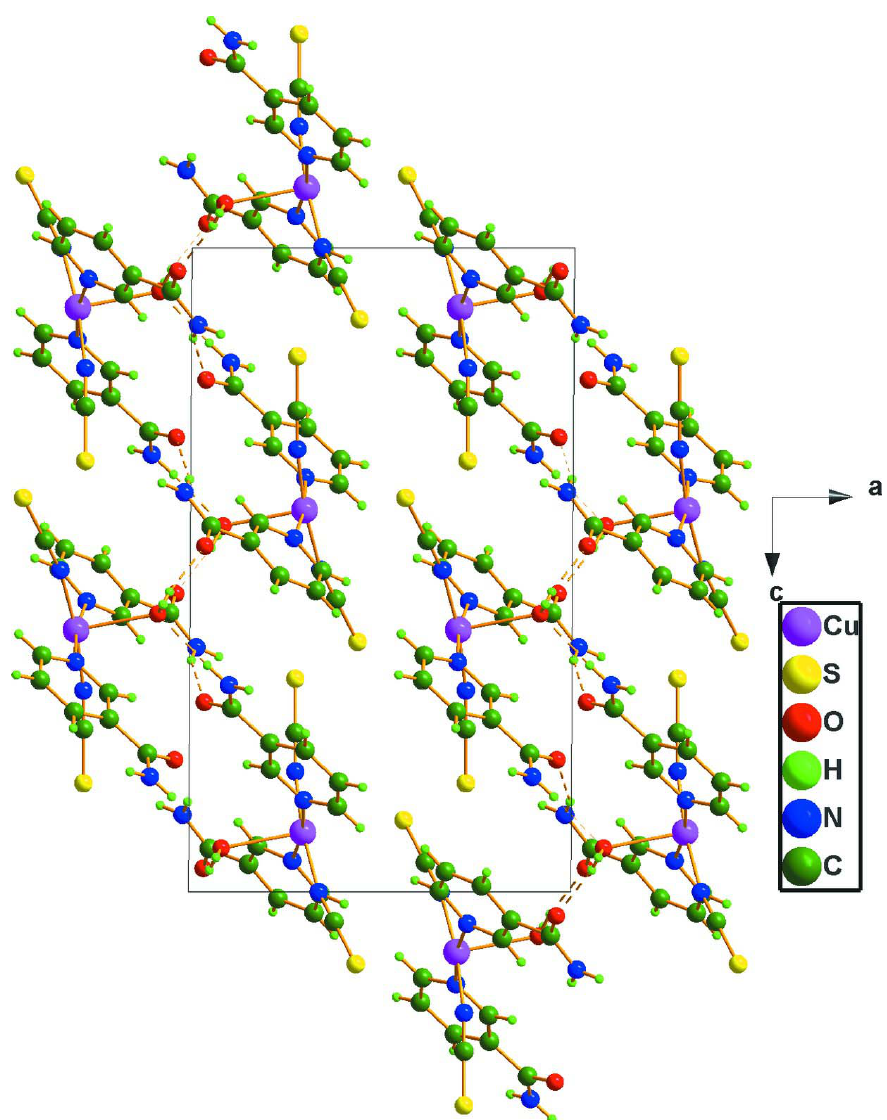
Figure 2 The layered hydrogen-bonded network in (I) viewed down the b axis direction. Hydrogen bonds are shown as dashed